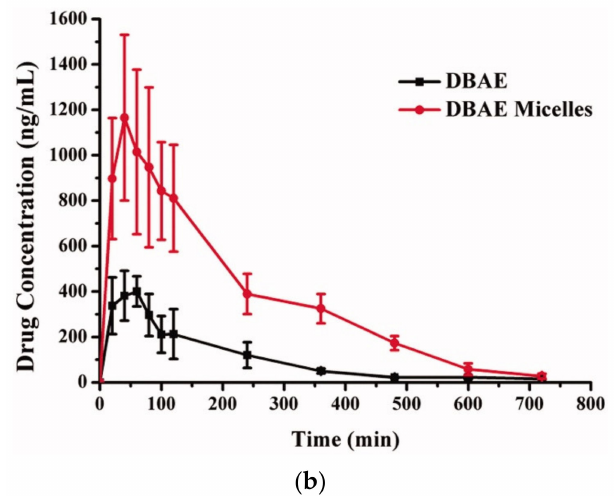
Figure 5. Effects of mixed micelles on ( a ) intestinal absorption and ( b ) pharmacokinetic properties of DBAE. * p < 0.05, *** p < 0.01. Reprinted from [127] by permission of Taylor &Francis Ltd. (London,